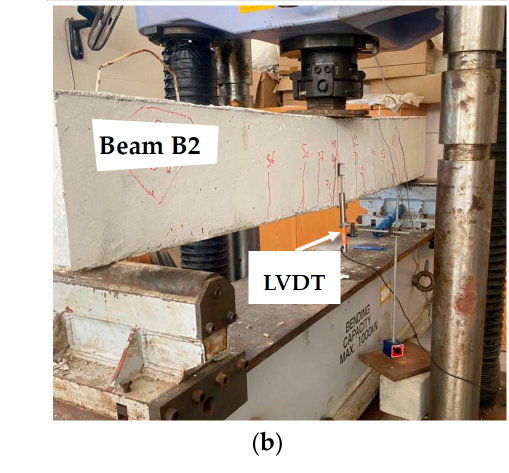
Figure 2. Test setup ( a ) Schematic; ( b ) Photo.